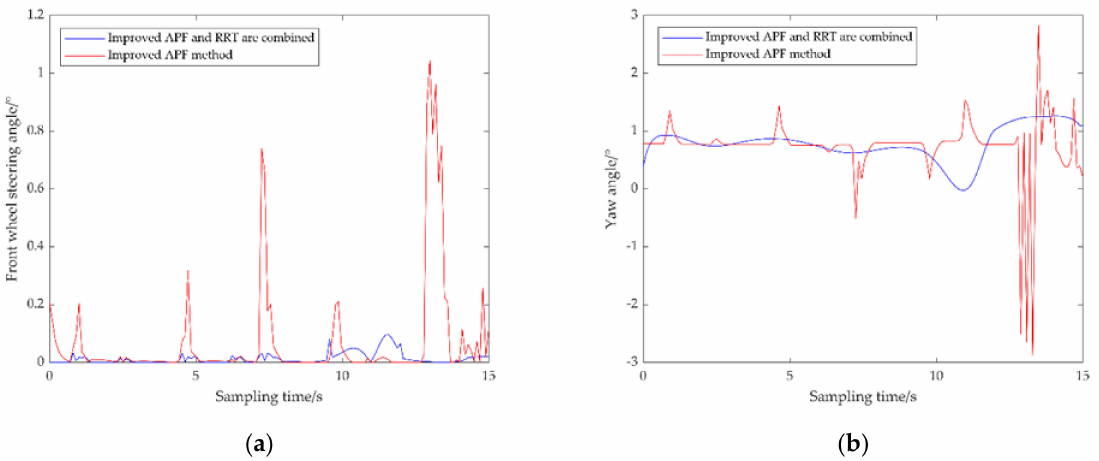
Figure 9. ( a ) Front–wheel steering angle generated by MPC tracking trajectory; ( b ) Yaw angle gen–erated by MPC tracking